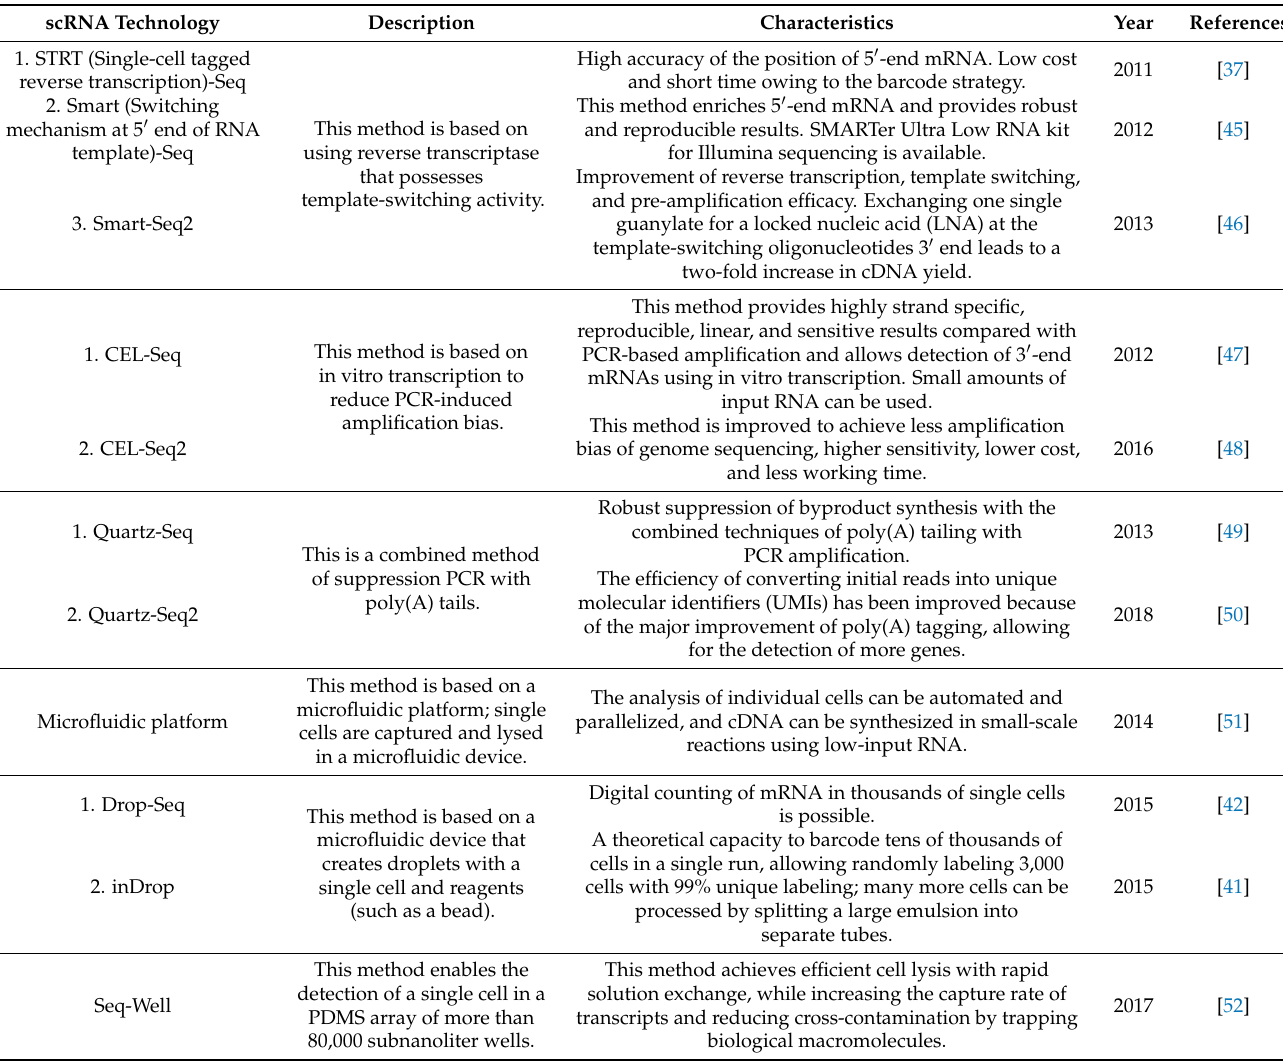
Table 1. scRNA-seq methodology used for